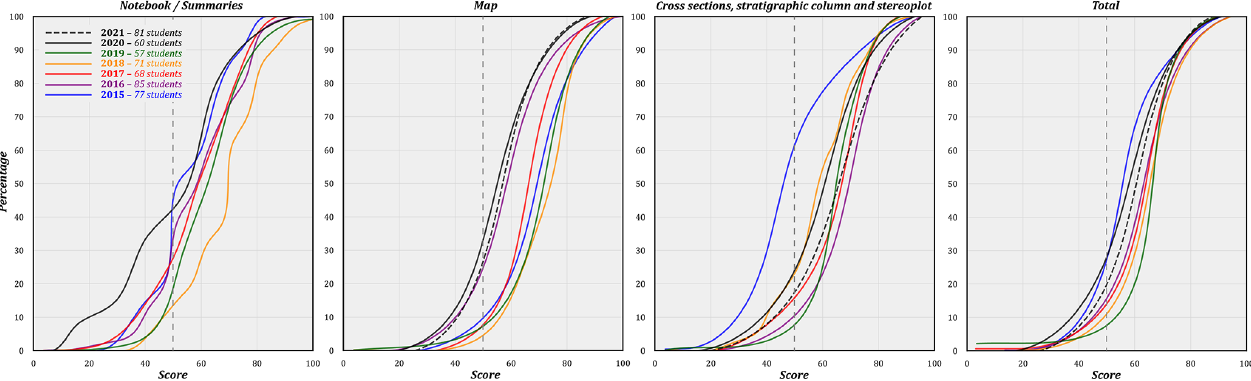
Figure 8. Cumulative plots of the students’ grades on different tasks throughout the years. The grades from the Esla Mapping Project (black colours, years 2020 and 2021) are, in general, lower than previous years’. Note that during 2021 summaries were not evaluated and were not accounted for in the final